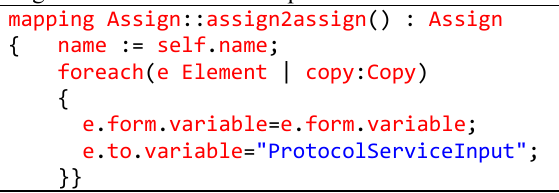
Fig. 12. The BPEL